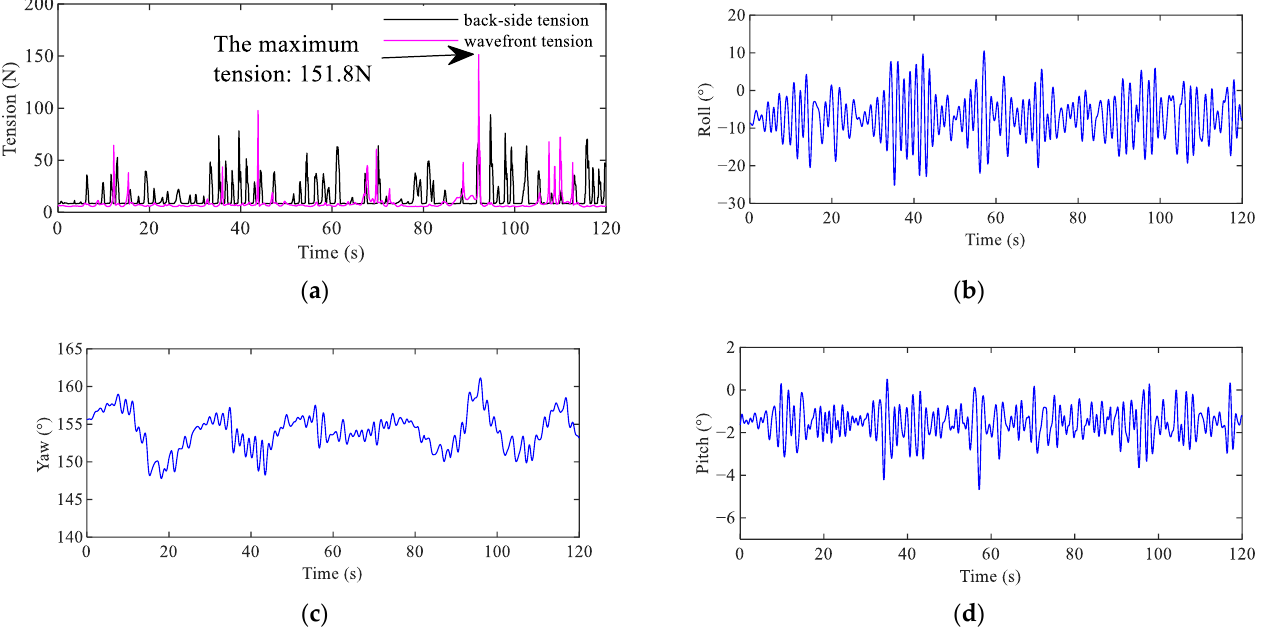
Figure 7. The time-history curves of mooring cable tension, roll, pitch, and yaw for Mooring Mode D under Wave Condition g. ( a ) The tension of two mooring cables; ( b ) Roll; ( c ) Yaw; ( d ) Pitch.